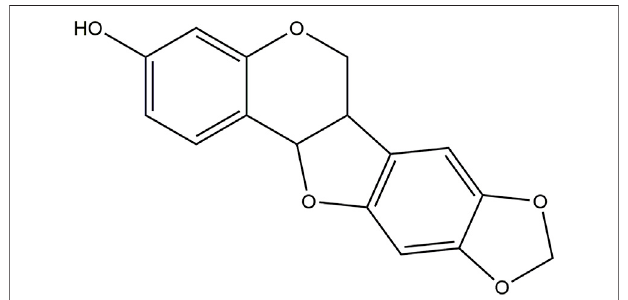
FIGURE 1 | The chemical structure of MA constructed using